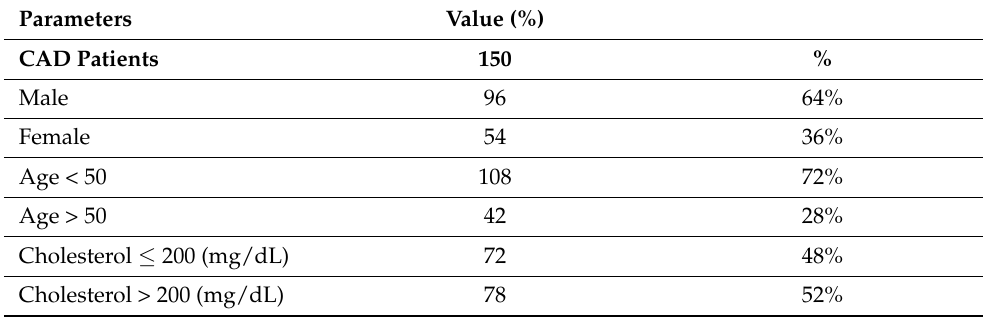
Table 2. Demographic features of biochemical parameters of coronary artery disease patients.